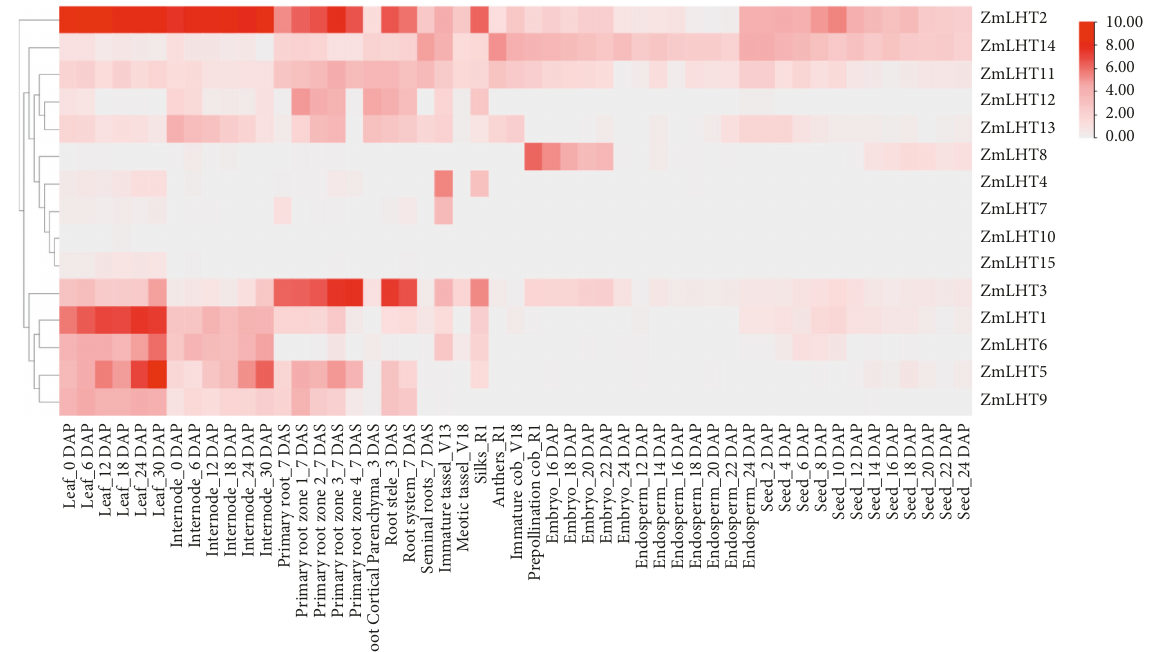
Figure 6: Clustering of maize LHTs based on gene expression. Heat map showing hierarchical clustering of genes based on gene expression in different tissues and at distinct developmental stages mentioned at the top. Clustering was based on log2 transformed FPKM